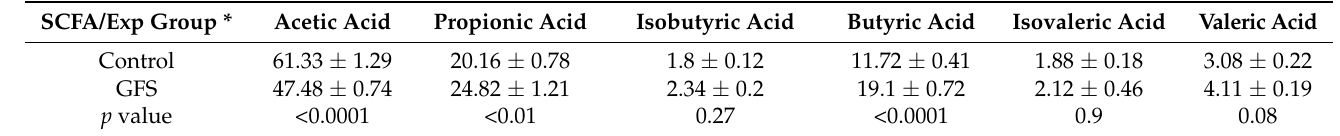
Table 6. Short-chain fatty acids content in colonic digesta collected from piglets.